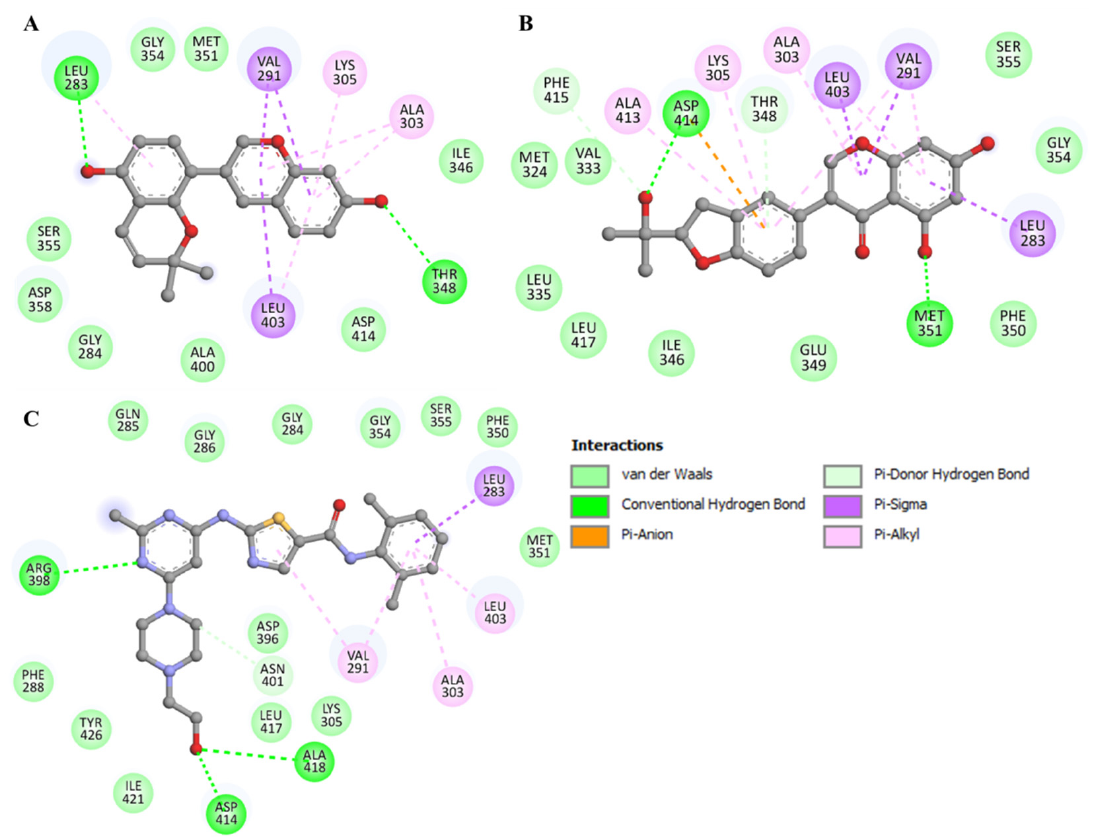
5 of 14 Figure 1. Molecular interactions of ( A ) YES1 with Glabrene (green), LIC (yellow), and Dasatinib (magenta) ( B ) Cartoon illustration of protein–ligand interactions. ( C ) Electrostatic potential surface view of YES1 bound with the selected compounds. The detailed interaction of both compounds was further explored for their interac- tions with the active/critical site residues of YES1. It is clear from Figure 2 that Glabrene and LIC share common interactions while interacting with the ATP-binding site residue